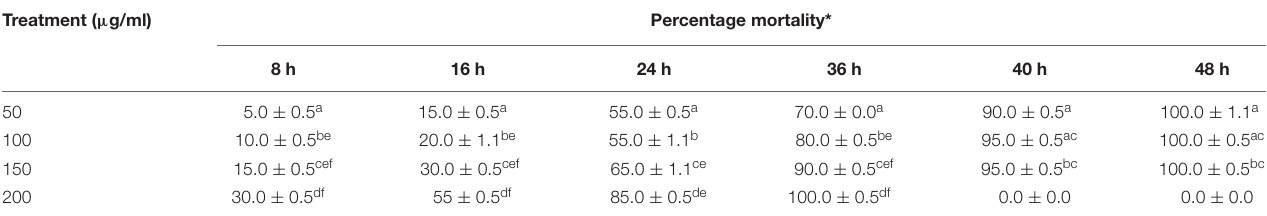
TABLE 4 | Insecticidal activity of Bio-AgNPs. Treatment ( µ